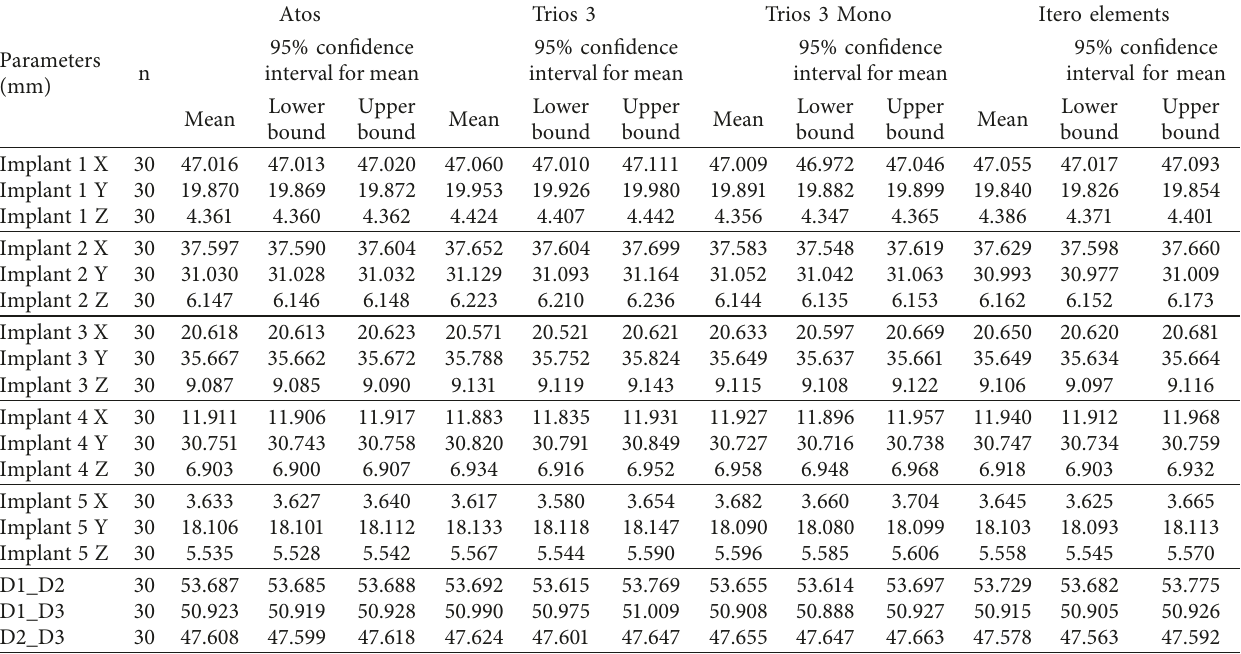
Table 3: Results of mean and 95% confidence interval for the mean of all implants and interarch distances.